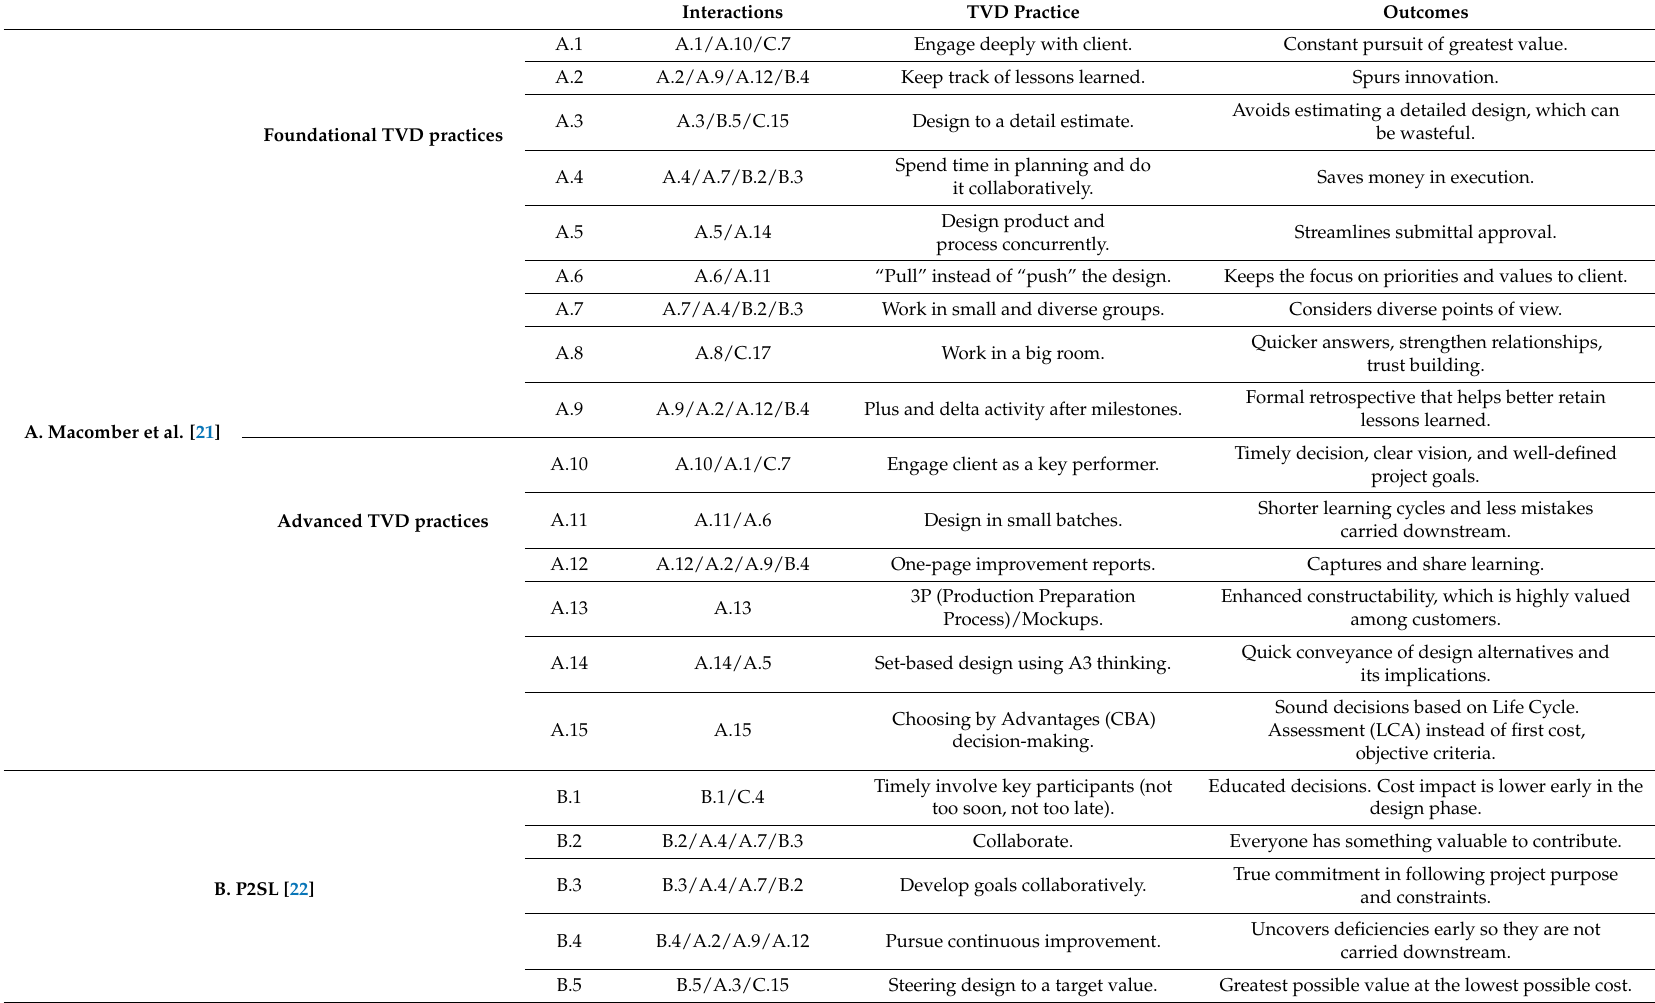
Table 1. TVD Benchmark